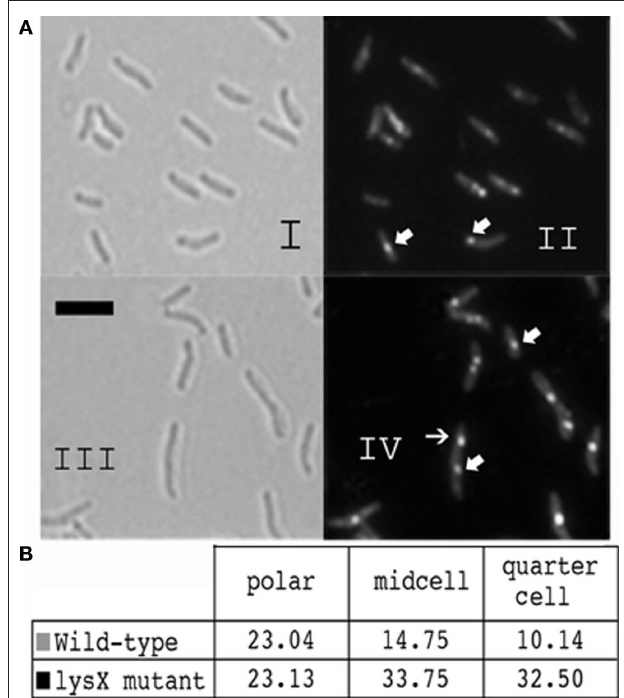
FiguRe 7 | Cardiolipin staining of the M. tuberculosis lys X mutant. (A) Cultures were stained with NAO as described above, cells were fixed in paraformaldehyde and observed using fluorescence microscopy. Images I and III are brightfield 100 × magnification, with scale bars representing 3 μm. Images II and IV show NAO bound to regions where cardiolipin is present. (B) Fluorescence images of NAO-stained cells were analyzed and type of staining was recorded for about 200 cells from each